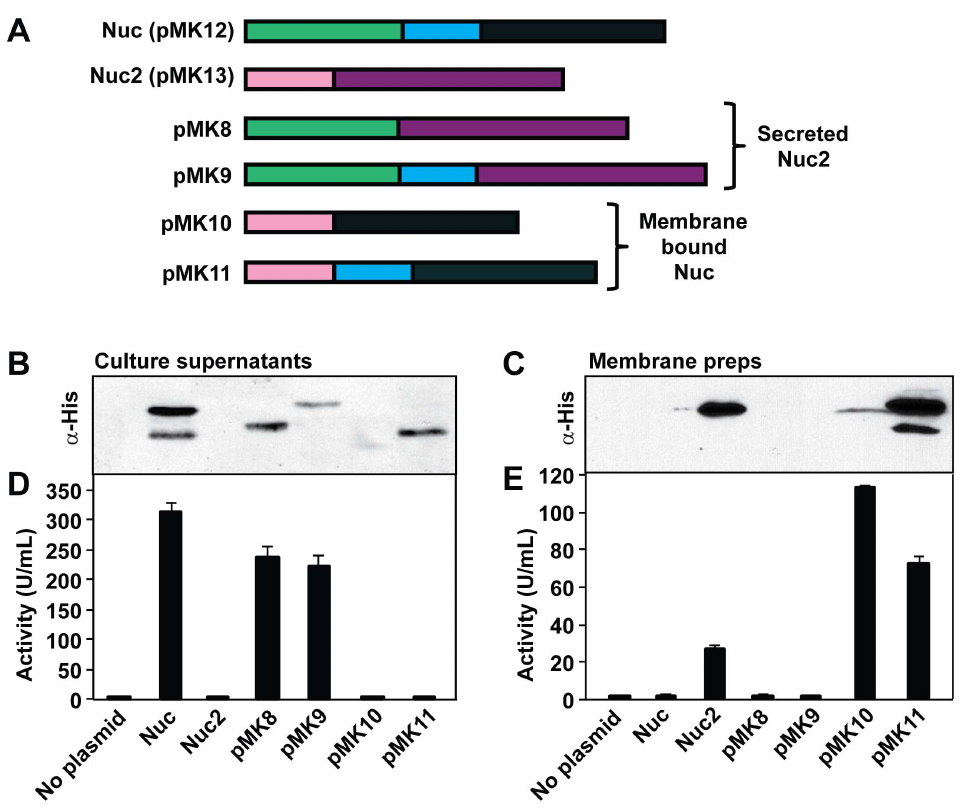
Figure 7. Activity of Nuc/Nuc2 chimeric proteins. Chimeras consisting of combinations of Nuc and Nuc2 N- and C-terminal protein domains were constructed. Each chimera was constructed to include a His 6 -tag on the C-terminal protein domain. A . Schematic showing the Nuc/Nuc2 chimeric proteins constructed, with Nuc domains colored in teal and Nuc2 domains colored in purple (see Fig. 1A for additional description of domains and processing sites). Chimeras constructed include, from the top down: Nuc control (pMK12), Nuc2 control (pMK13), Nuc signal sequence fused to the Nuc2 active domain (pMK8), Nuc signal sequence and NucB leader fused to the Nuc2 active domain (pMK9), Nuc2 membrane anchor fused to NucA (pMK10) and Nuc2 membrane anchor fused to NucB (pMK11). Each construct was expressed in a S. aureus nuc mutant (strain AH1680) for 15 hr, and culture supernatant was saved and membranes purified. Anti-His immunoblots were performed to detect the presence of C-terminal His 6 -tag on chimeric proteins in culture supernatants ( B ) or membrane ( C ) fractions. FRET activity assays were performed to detect nuclease activity in culture supernatants ( D ) and membrane ( E) fractions. The nuc mutant strain was included as a negative control (called ‘‘no plasmid’’).